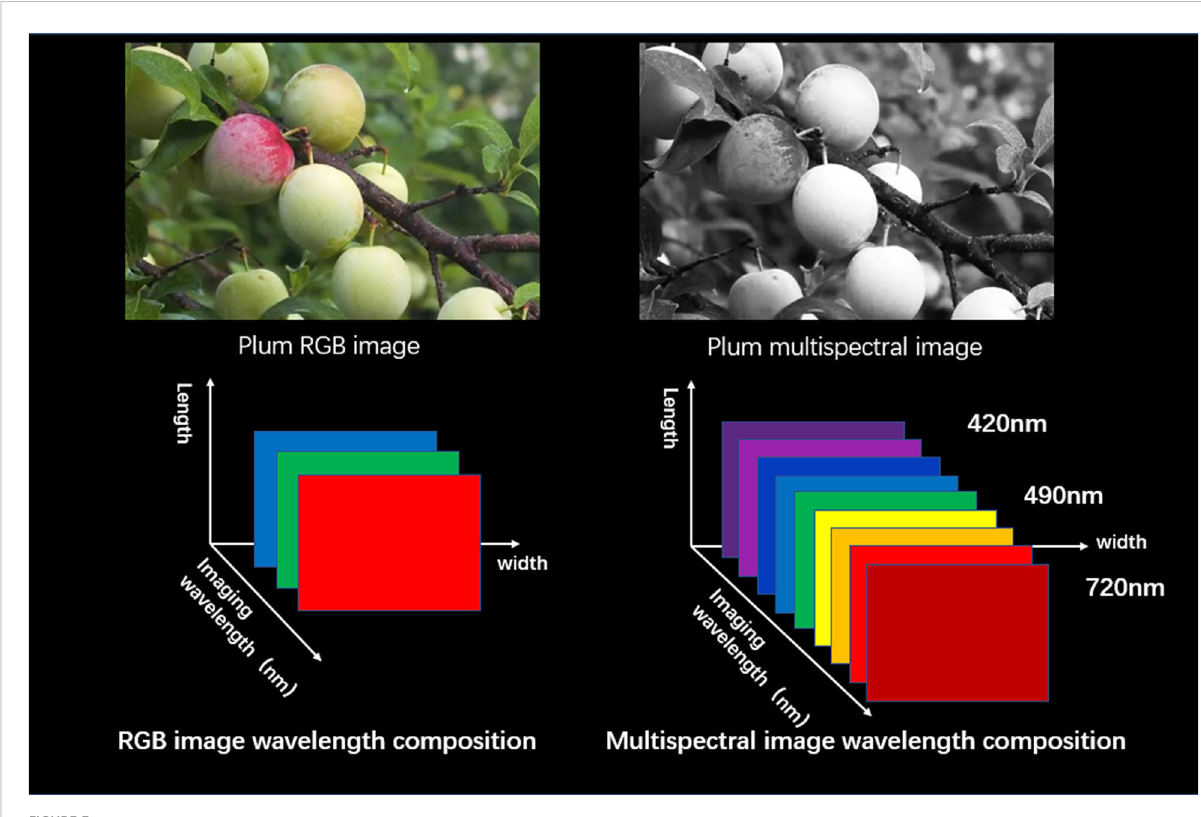
FIGURE 3 Wavelength composition of multispectral